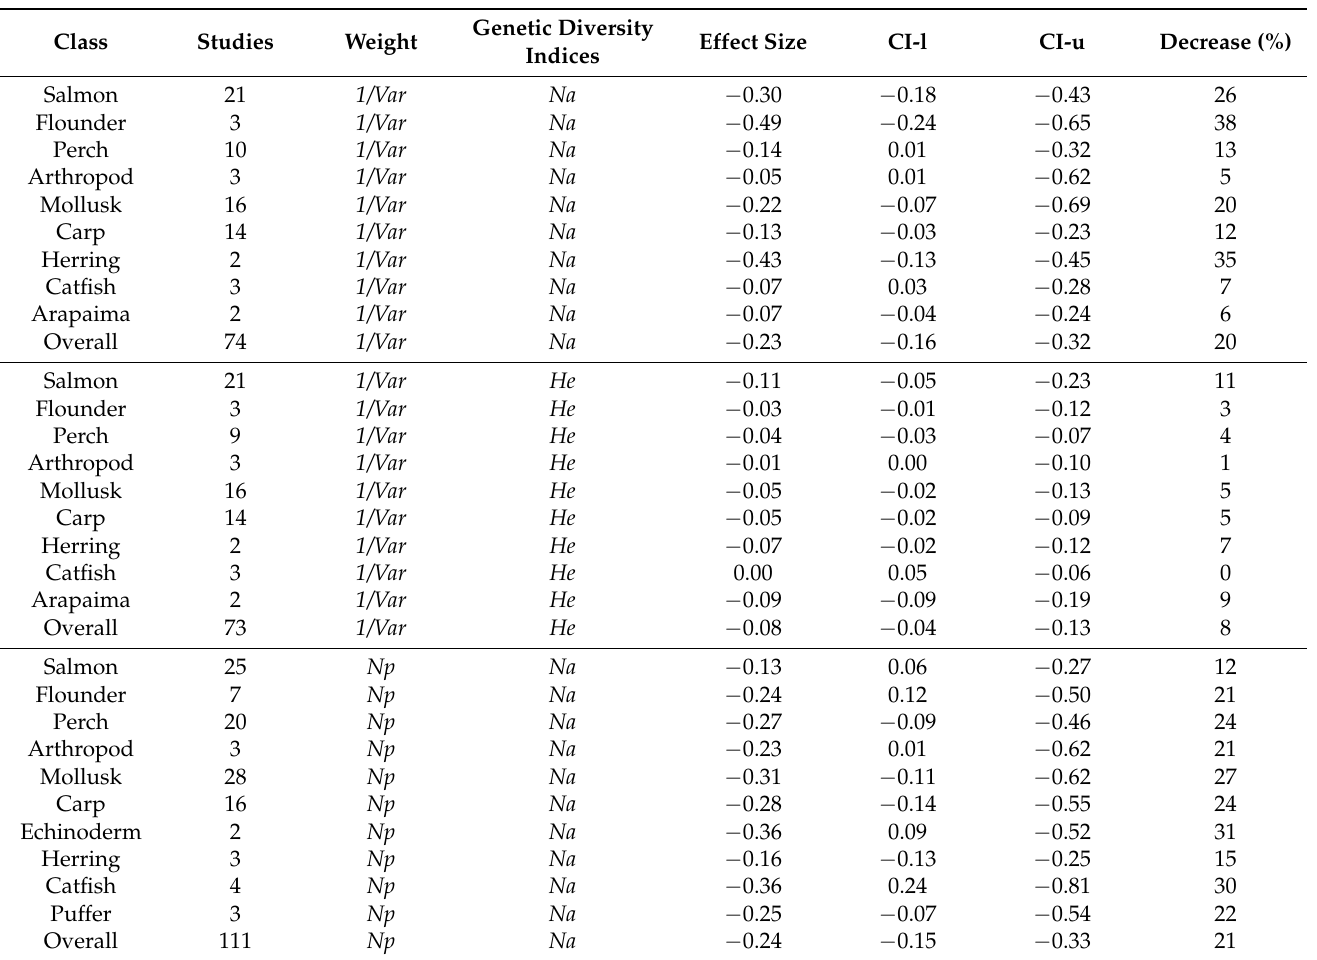
Table 2. Meta-analysis of the effect of aquaculture on different aquatic